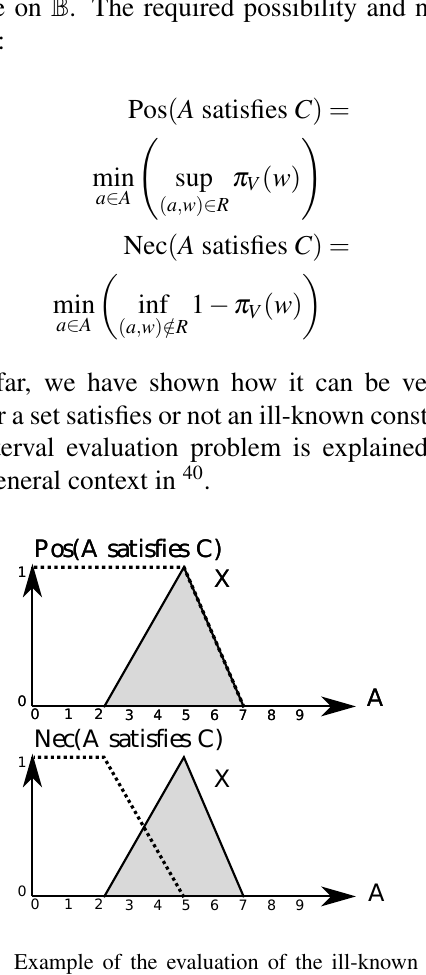
Fig. 1. Example of the evaluation of the ill-known con- straint C (cid:44) ( (cid:54) , X ) , X = [ 5 , 3 , 2 ]